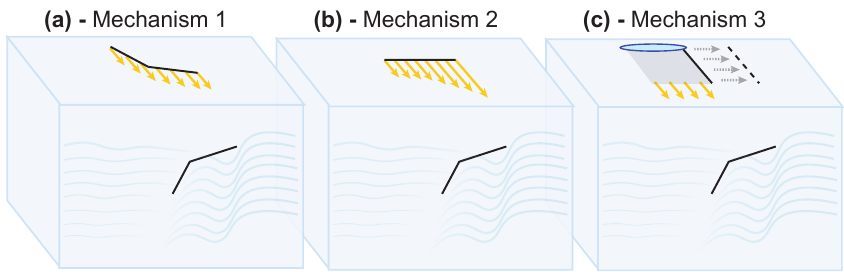
Figure 4. Schematic detailing end-member mechanisms for unconformity formation with the distinctive kinked geometry observed in the radar data: (1) a stationary surface feature orthogonal to flow that mirrors the shape of the unconformity in the subsurface, advecting away and buried with constant velocities; (2) a stationary surface feature orthogonal to flow that is advected and buried in a spatially variable velocity field, with velocity gradients that mirror depth gradients of the structure; or (3) a feature whose boundaries drift with time, with the slope of the unconformity varying as a function of the rate of drift. We believe that mechanism (3) is most consistent with the unconformity geometry, with kink positions corresponding to the dates of ice-dynamic changes in the